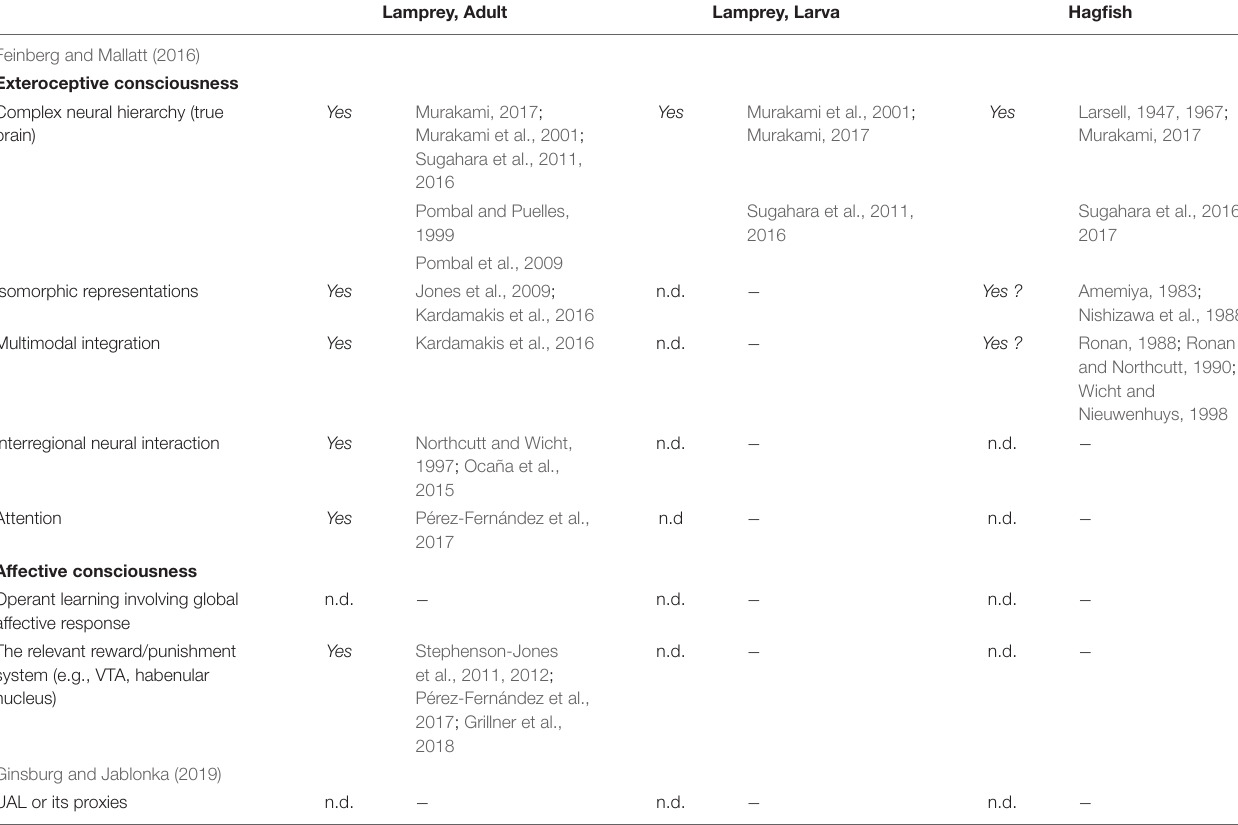
TABLE 1 | The criteria of consciousness and neurobiological evidence in the